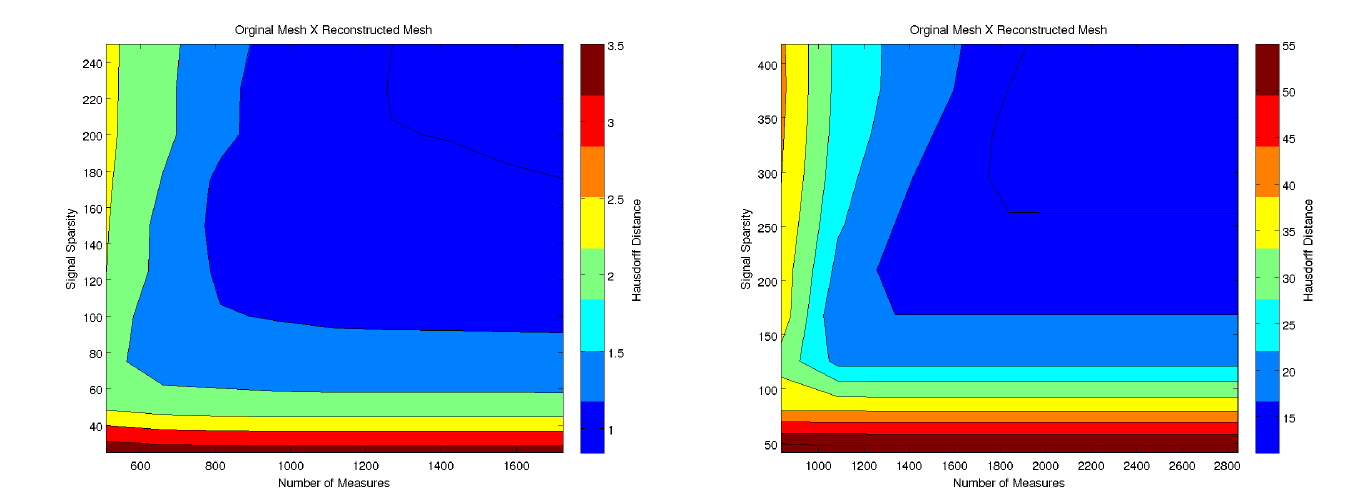
Figure 7: Fandisk (Hausdorff Distance between the original mesh and the reconstructed mesh): Gaussian measurement matrix. The average processing time for reconstruction was 27.2336 seconds.